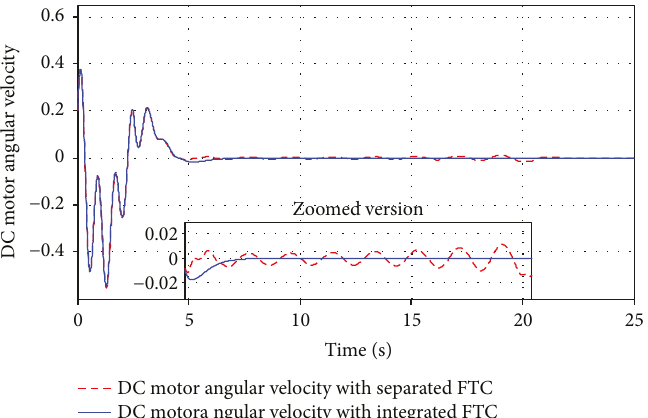
Figure 8: Second closed-loop system output response: output response with the separated FE-based FTC (red line) and output response with the integrated FE-based FTC (blue